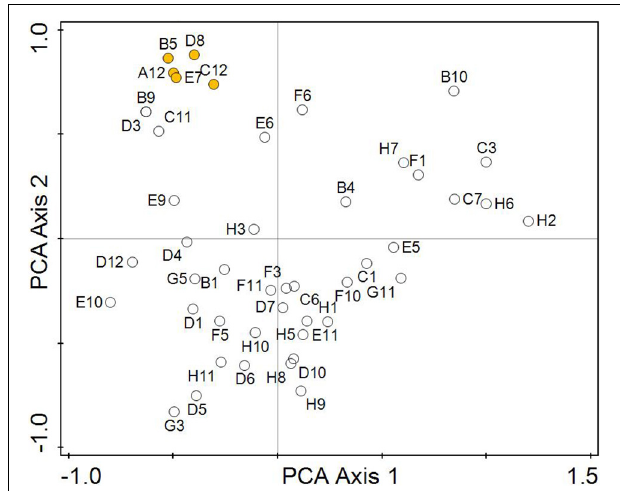
FIGURE 5 | Analysis of the suitability of FF-biochemical tests from the BIOLOG system for testing the phenotypic properties of Aspergillus niger isolates in relation to pH of environment. The designation of the biochemical tests corresponds to Table 2 . The orange centroids correspond to sugar